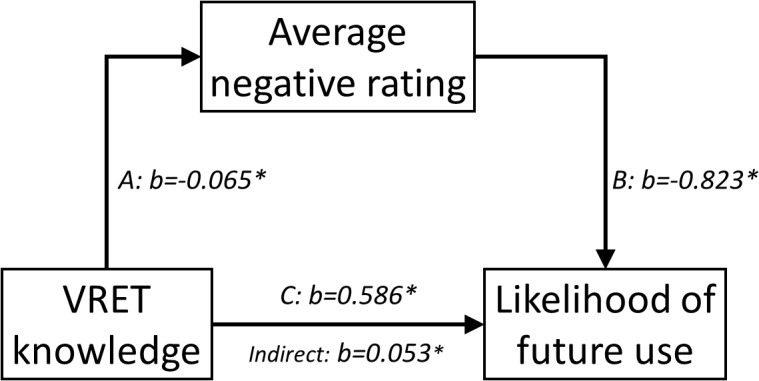
Mediation model.